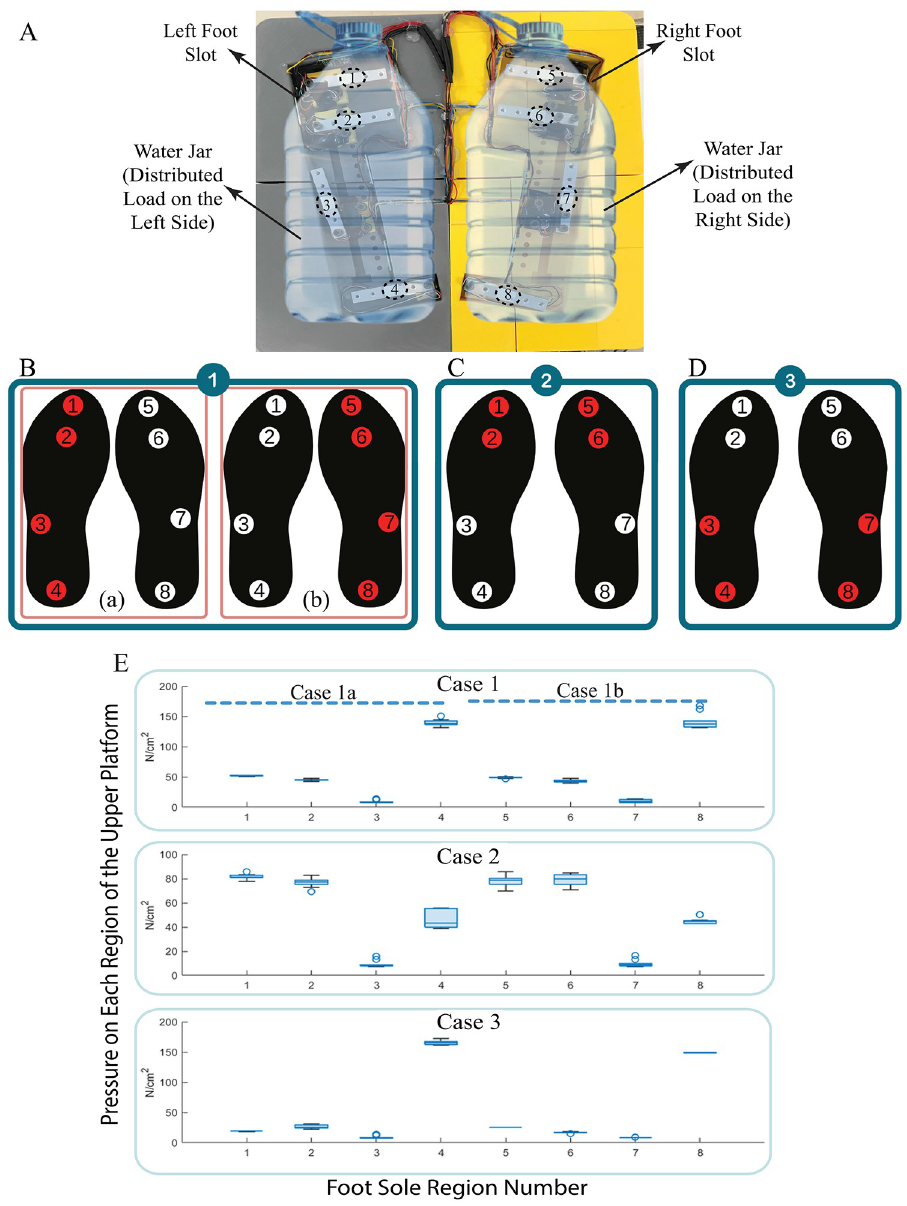
Fig 12. Experimental procedure for the evaluation of upper platform in the static condition (A) Two water-filled jars are distributed over the upper platform (B) Pressure distribution of the distributed load on the left side of the platform only (Case 1a: standing on the left foot scenario), and right side only (Case 1b: standing on the right foot scenario) (C) Pressure distribution on the front half of the platform (Case 2: standing forefoot scenario) (D) Pressure distribution on the rear half of the platform (Case 3: standing on the rearfoot scenario) (E) Pressure distribution evaluation test statistics. eversion movements sequentially. Each movement is repeated 10 times (S2–S5 Figs) by the parallel manipulator for 1 minute, and the data gathered from each load cell is sampled at a sampling time of 1 ms. The mean and standard deviation of the collected data for each load cell is presented with box plots in Fig 13A. The two plots in Fig 13A correspond to pressure distributions of the left and right feet, respectively. The experimental results indicated in